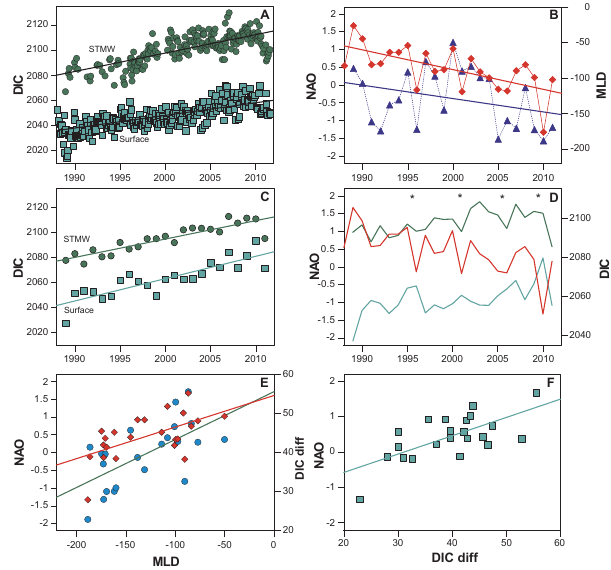
Fig. 3. Time-series and relationships between DIC, mixed layer depths (MLD) and NAO index from 1988 to 2011 at the BATS (Bermuda Atlantic Time-series Study; 31 ◦ 40 0 N, 64 ◦ 10 0 W) site lo- cated near Bermuda in the NW Atlantic Ocean. Slopes and statis- tics of regressions are listed in Table 1. (A) Time-series of DIC in surface (DIC surface ; µmolkg − 1 ; light green symbols) and STMW (DIC STMW ; µmolkg − 1 ; dark green symbols) waters. (B) Time- series of winter NAO (JFM; red symbols and line) and mixed layer depth (m; blue symbols and line). (C) Time-series of winter (JFM) DIC in surface (µmolkg − 1 ; light green symbols and line) and STMW (µmol kg − 1 ; dark green symbols and line) waters. (D) Time series of winter (JFM) DIC in surface (µmolkg − 1 ; light green line) and STMW (µmolkg − 1 ; dark green line) waters and winter NAO (JFM; red line). The surface and STMW DIC data are corrected for long-term trends and so represent anomalies relative to long- term trends. (E) . Scatterplot of winter (JFM) NAO (red symbols) and DIC difference between STMW and surface (µmolkg − 1 ; blue symbols) against mixed layer depth (m). (F) . Scatterplot of winter (JFM) NAO against DIC difference between surface and STMW (µmolkg − 1 ; green